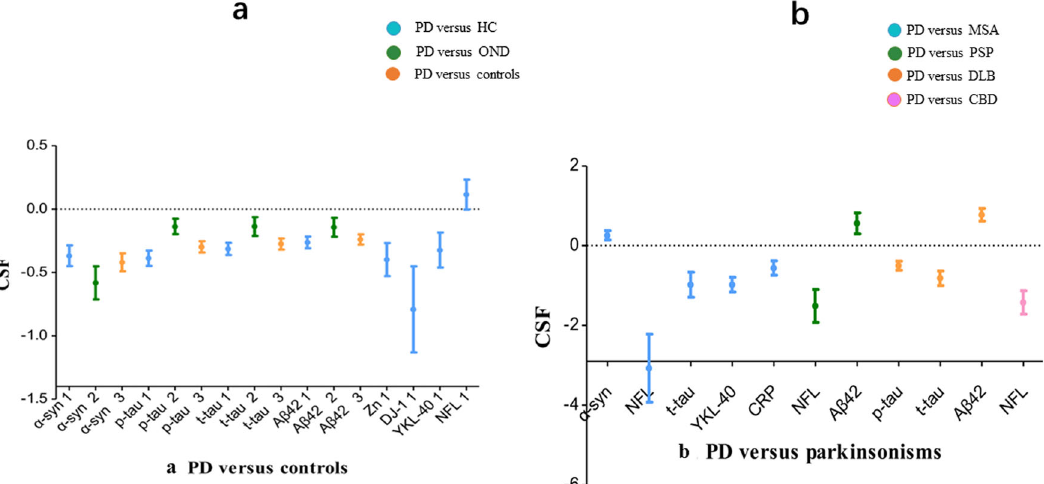
Fig. 3 Meta-analysis for CSF biomarker performance measured with the effect size (ES) and 95% con fi dence interval (CI) for PD versus control or parkinsonism patients. a The biomarkers illustrated in blue and marked as 1 were signi fi cantly different between PD patients and HC. The biomarkers illustrated in green and marked as 2 were signi fi cantly different between PD and OND patients. A signi fi cant difference was identi fi ed between the PD patients and those in the OND and HC groups combined for the orange-labeled biomarkers marked as 3. b The biomarkers illustrated in blue were signi fi cantly different between PD and MSA patients. The biomarkers illustrated in green were signi fi cantly different between PD and PSP patients. A signi fi cant difference was observed between the PD and DLB patients for the orange-labeled biomarkers. The biomarker marked pink was signi fi cantly different between the PD and CBD patients. PD Parkinson ’ s disease, OND other neurodegenerative diseases, HC healthy control, MSA multiple system atrophy, DLB dementia with Lewy bodies, PSP progressive supranuclear palsy, CBD cortico-basal degeneration, α -syn α -synuclein, A β 42 the 42-amino-acid form of A β , t-tau total tau, p-tau phosphorylated tau, NFL neuro fi lament light-chain protein, YKL-40, CHI3L1 chitinase-3-like protein